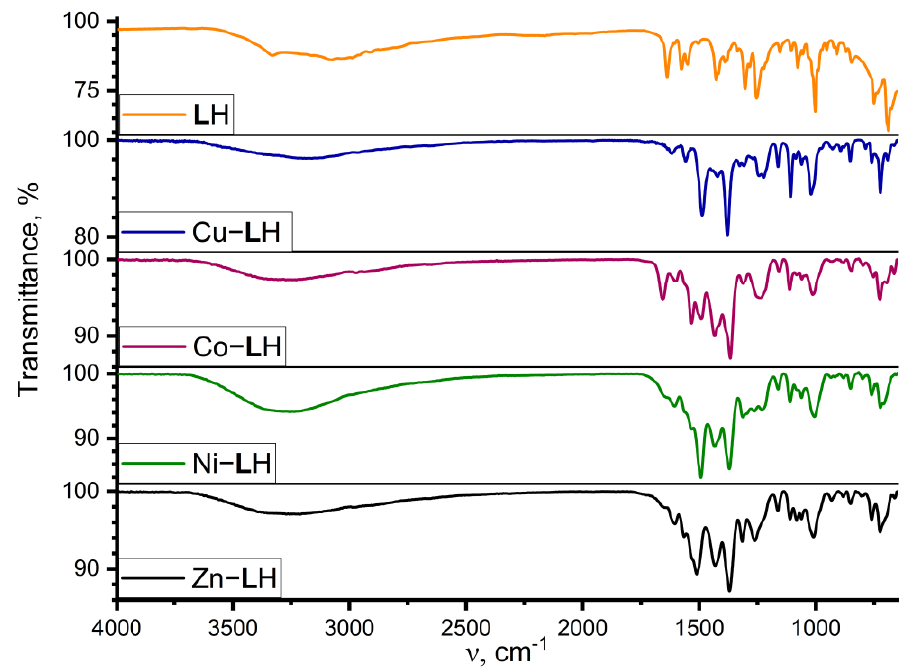
Figure 5. Solidstate IR spectra of the title compounds.